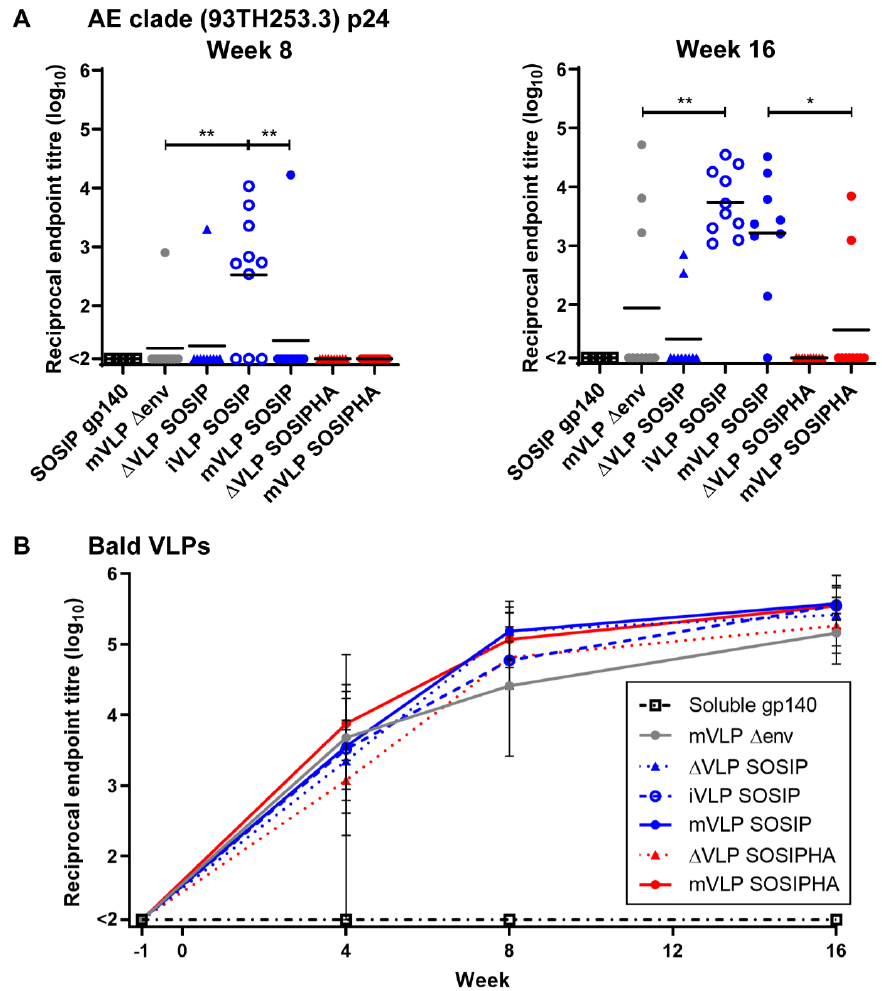
Figure 7. Mouse serum Gag-specific and Bald VLP-specific antibody responses. ( A ) Reciprocal endpoint serum antibody titers (log 10 -transformed) at week 8 and 16 against AE clade (93TH253.3 strain) p24 as determined by p24-capture ELISA. Each point represents an individual animal. The black bar represents the mean titer. The endpoint dilution titer cut-off was defined as 3 times the average OD measured for the same serum dilution of adjuvant-only-vaccination group mice sera sampled at the same time point. Significance was determined by a Kruskal–Wallis test followed by Dunn’s multiple comparison test. p -values are indicated as p < 0.05 (*), < 0.01 (**). Multiple comparisons were performed as follows: mVLP Δenv vs. iVLP SOSIP, mVLP Δenv vs. mVLP SOSIP, mVLP Δenv vs. mVLP SOSIPHA, iVLP SOSIP vs. mVLP SOSIP, and mVLP SOSIP vs. mVLP SOSIPHA. ( B ) Reciprocal endpoint serum antibody tires (log 10 -transformed) at weeks –1, 4, 8, and 16 against Bald VLPs (mVLP Δenv) as determined by VLP ELISA. Each point represents the mean, and the error bars show the range of titers for all animals within the vaccination group. The endpoint dilution titer cut-off was defined as 3 times the average OD measured for the same serum dilution of adjuvant-only-vaccination group mice sera sampled at the same time point. For both ( A , B ), the lowest reciprocal dilution assayed was 100, and titers less than 100 were recorded as “<2”. Data are representative of 2 independent experiments.